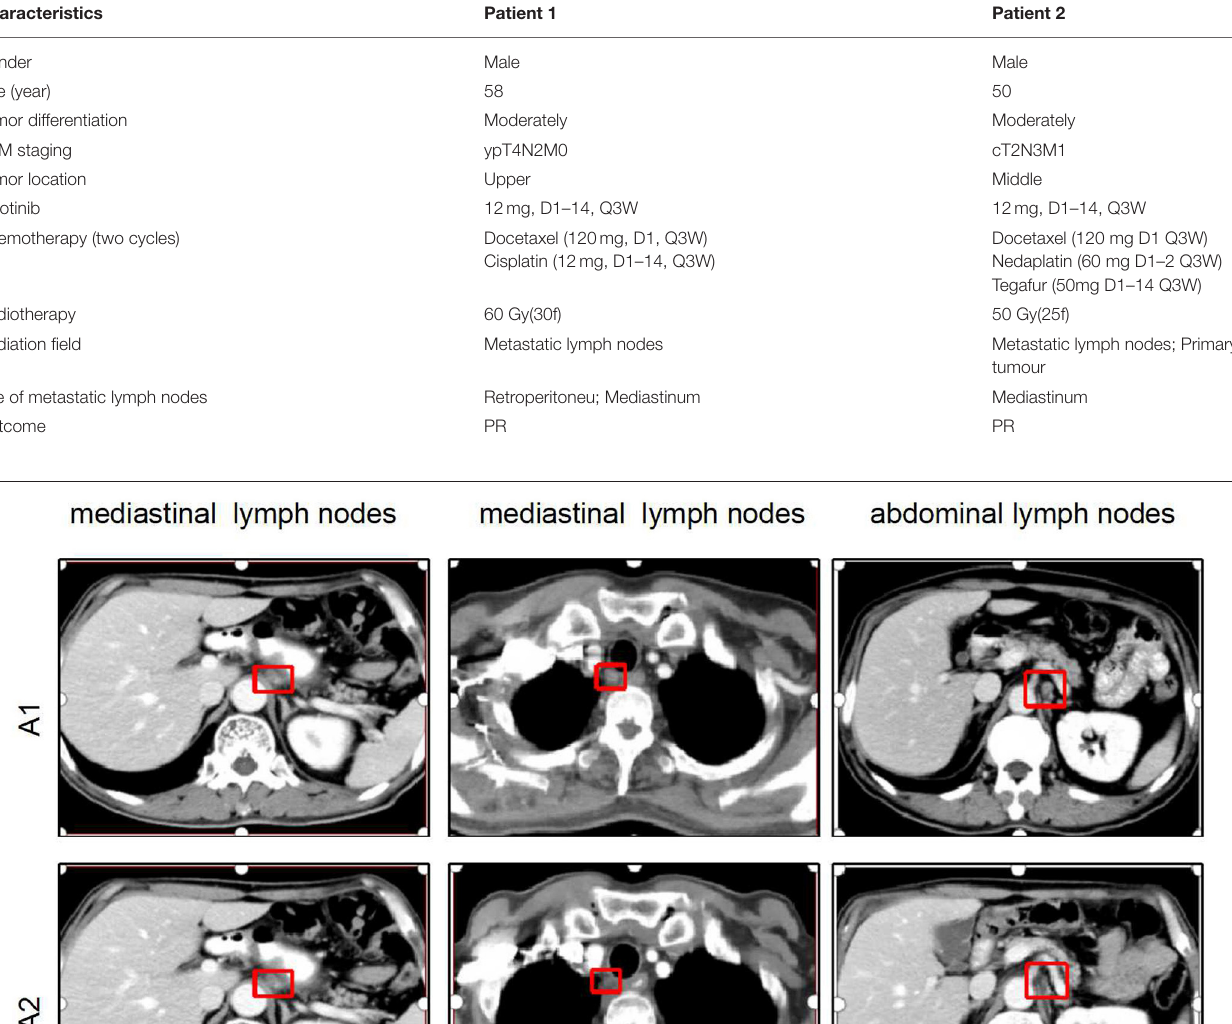
TABLE 3 | Clinical characteristics of two involved patients.